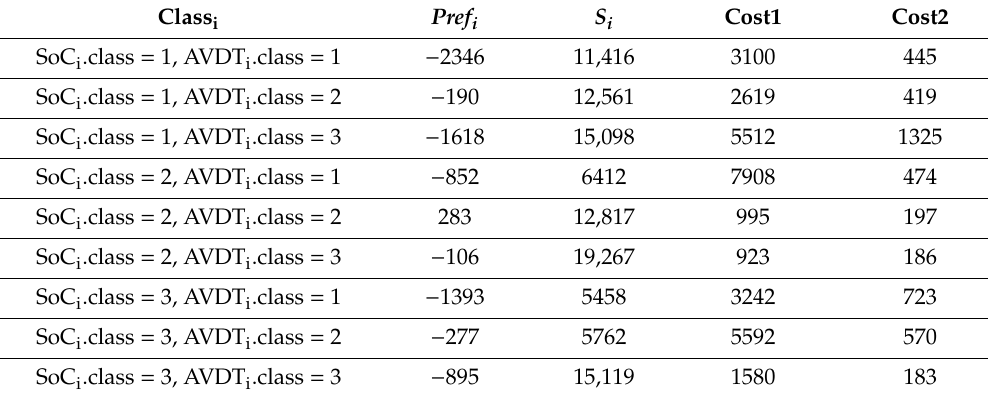
Table 3. Optimal Solution and Relative Costs.